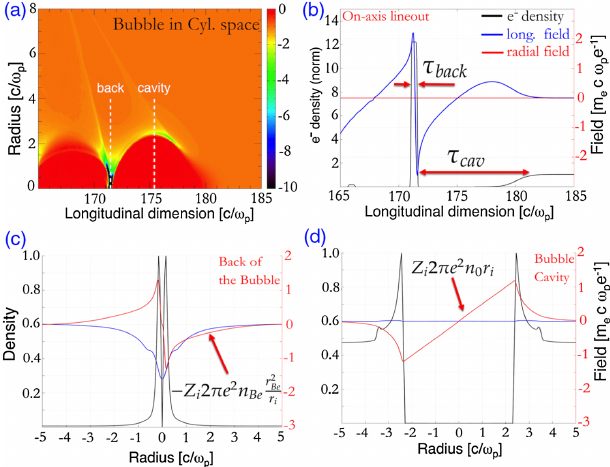
FIG. 4. Ion dynamics in longitudinally asymmetric phases of the radial forces in an electron bubble. (a) Electron density of a bubble in 2D cylindrical real space. (b) Longitudinal on-axis profile of the electron density (black), longitudinal field (blue), focusing field (red). (c) Radial-field profile close to the back of the bubble. This is the focusing suck-in phase for the ions. (d) The fields at the center of the ion cavity of the bubble. This is the defocusing “ push-out ” phase for the